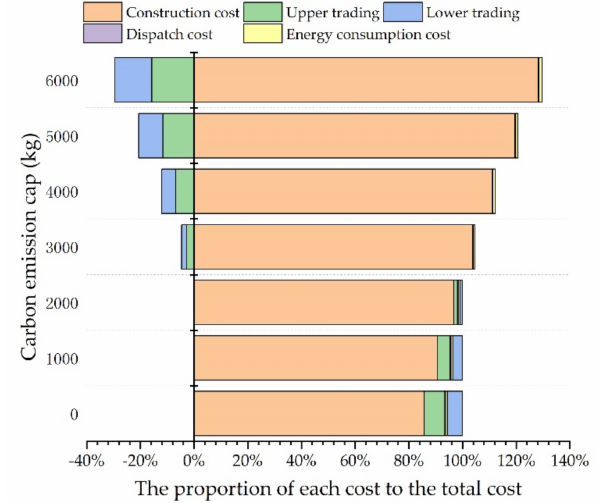
Figure 15. The relationship between the proportion of each cost and the carbon emission caps when the carbon trading price is 5